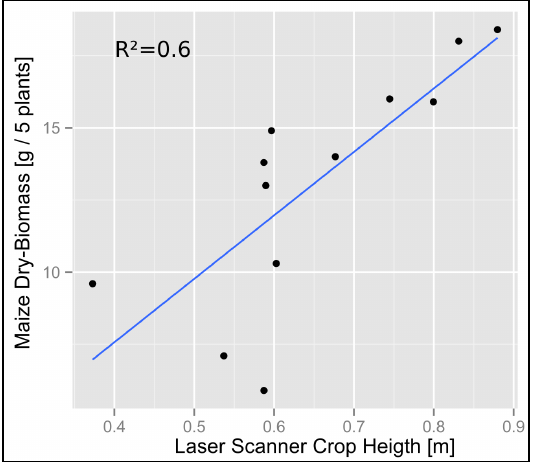
Figure 8. Regression of the CSM-derived plant height from July 3 rd and dry biomass. (N=12)